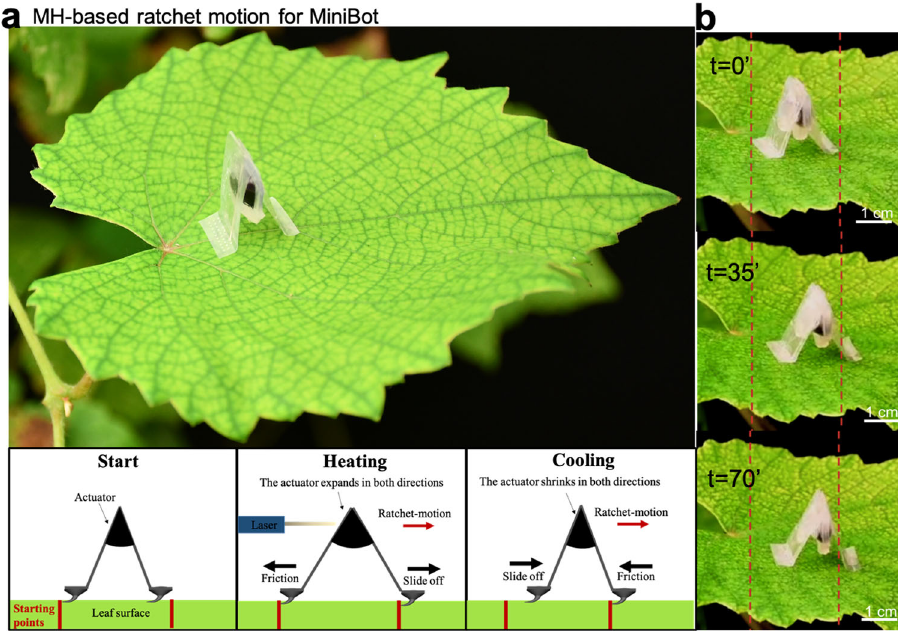
Fig. 5 Proof-of-concept demonstrator of ratchet-like motion on leaf surfaces via MH structures embedded in a miniature robot (MH-based MiniBot). a MH-based MiniBot over a V. lambrusca leaf. Inset: the interlocking mechanism enabled by the MH printed on the feet of the light-driven, low-weight MiniBot. When the 808 nm laser hits the actuator, the actuator expands and the MHs on the back foot create friction with the leaf surface. At the same time, the hooks on the front foot slide off enabling the demonstrator to move forward, and blocking backward motion. During the laser-off phase, when the fl uidic actuator cools down it shrinks. The MHs of the front foot then interlock and/or create suf fi cient friction to remain in the position obtained during expansion of the actuator, whereas the hooks on the back foot slide forwards, enabling on-leaf mobility of the robot. b Single frames at different timepoints showing the forward motion of MH-based MiniBot on the V. lambrusca